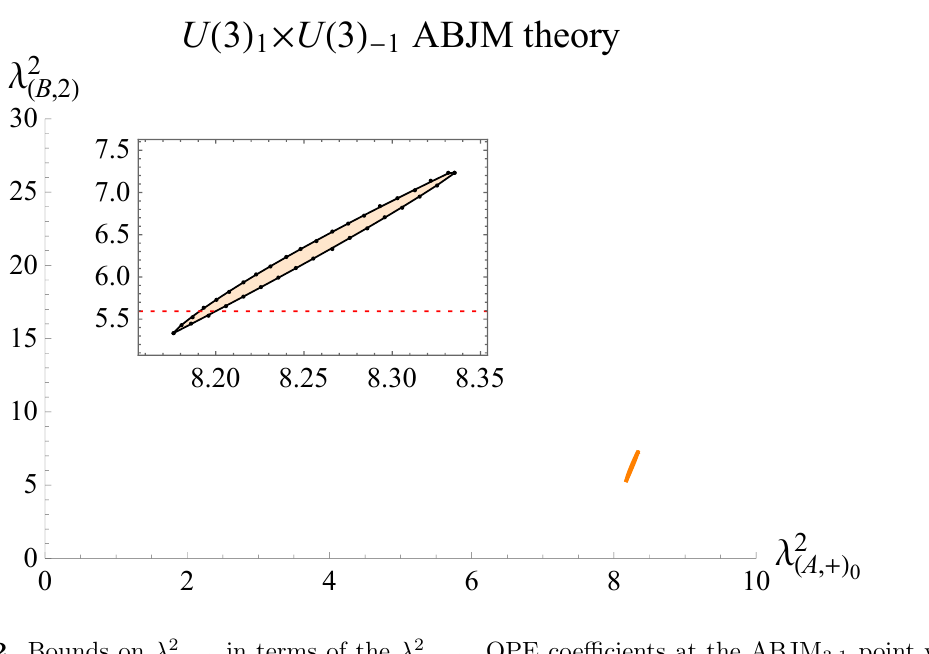
Figure 2 . Bounds on (cid:21) 2 in terms of the (cid:21) 2 OPE coe(cid:14)cients at the ABJM 3 ; 1 point with ( B; 2) ( A; +) 0 16 (cid:25) 0 : 340. The orange shaded region is the allowed island, while the red dotted line shows the c T exactly known value given in table 4 for (cid:21) 2 in this theory. These bounds were computed with ( B; 2) (cid:3) =